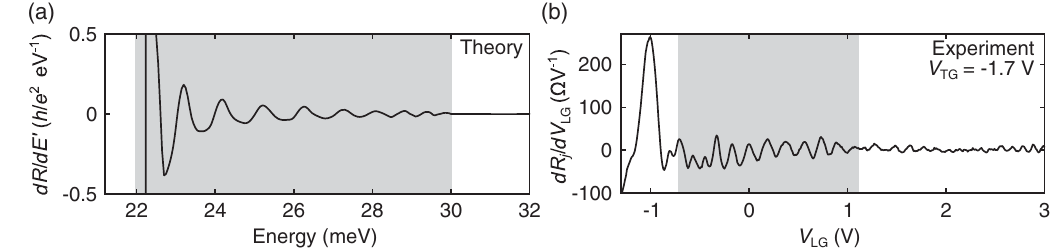
FIG. 5. (a) Differential resistance dR=dE 0 as a function of E 0 obtained from Fig. 4(c) using Eq. (6). Oscillations are present in the shaded energy region in which electrons and holes coexist. (h) Cut through Fig. 1(d) at V CNP marking electron and hole